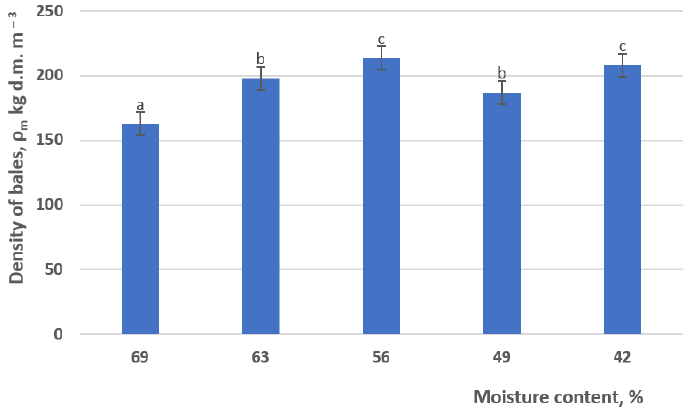
Figure 8. Bar chart of balage density in bales at different moisture content levels at pressing pressure of 9 MPa and plant material at a length of 183 mm. Different lowercase letters indicate a statistically significant difference at p ≤ 0.05. d.m., dry matter.